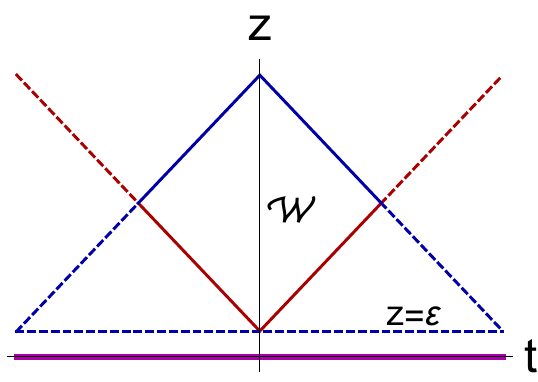
Figure 11 . The region W where one has to evaluate the gravitational action to compute the subregion complexity. The blue lines correspond to the entanglement wedge boundary, and the red lines are the WdW region null boundaries. Magenta line depicts the subregion of